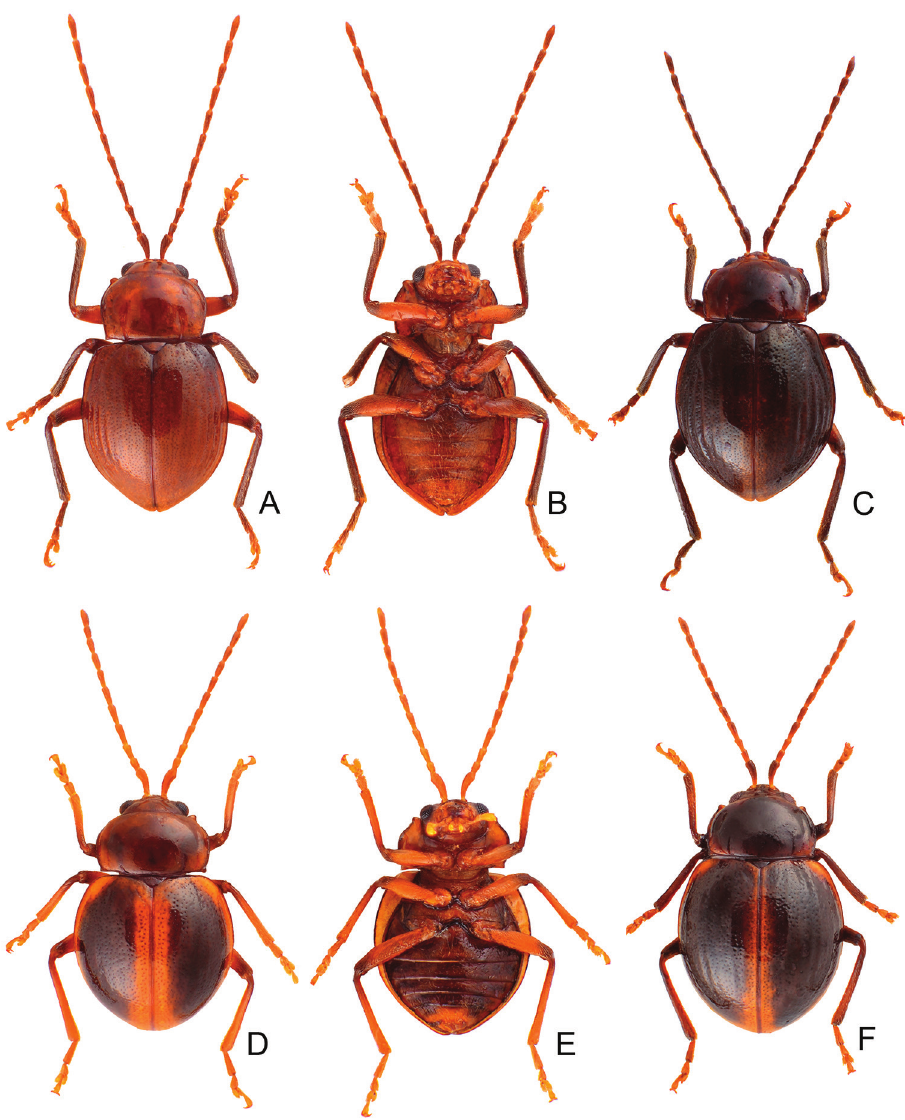
Figure 6. Habitus of Taiwanoshaira taipingshanensis sp. nov. and T. tsoui sp. nov. A T. taipingshanensis sp. nov., male, dorsal view B same, ventral view C same, female, dorsal view D T. tsoui sp. nov., male, dorsal view E same, ventral view F same, female, dorsal